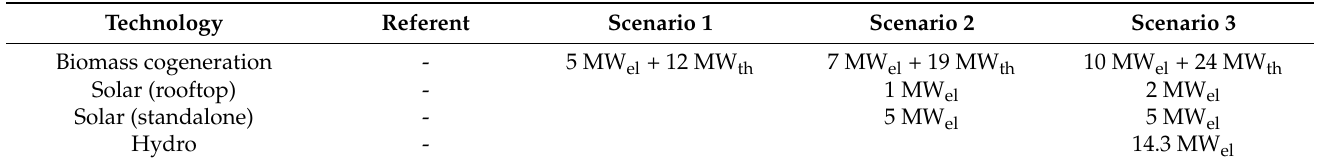
Table 2. RES deployment scenarios.